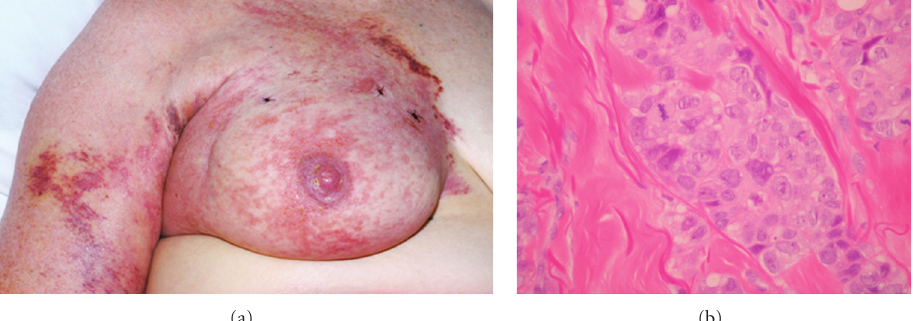
Figure 3: (a) The right breast displays patchy erythema with purpuric borders. (b) High-grade invasive ductal carcinoma infiltrating dermis, with mitotic